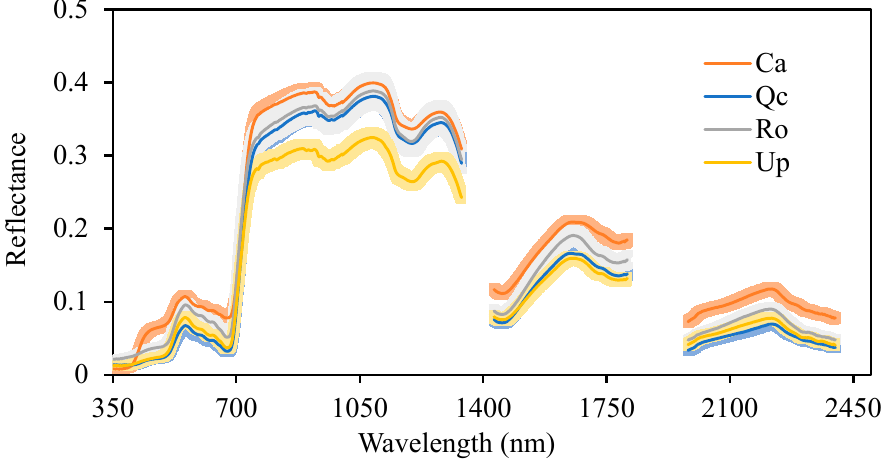
Figure 3. Spectral signatures of Ulex parviflorus (UP) Cistus albidus (Ca), Quercus coccifera (Qc) and Rosmarinus officinalis (Ro) in monospecific control stands. Means, n = 27 with standard errors. Measurements were carried out between 27 April and 10 May 2022.